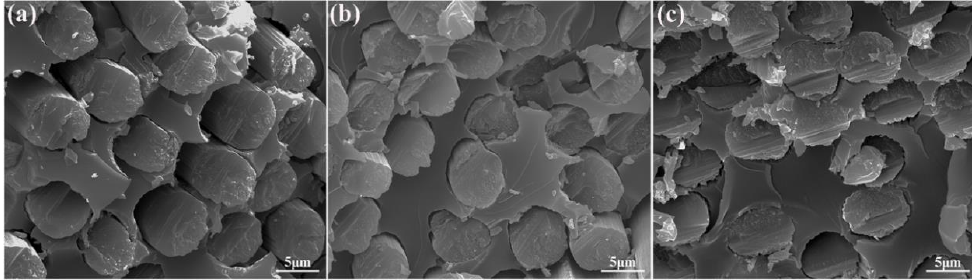
Figure 6. SEM morphologies of the fracture surface of composites reinforced with ( a ) untreated CF, ( b ) CF-OH, and ( c ) CF-cardanol.